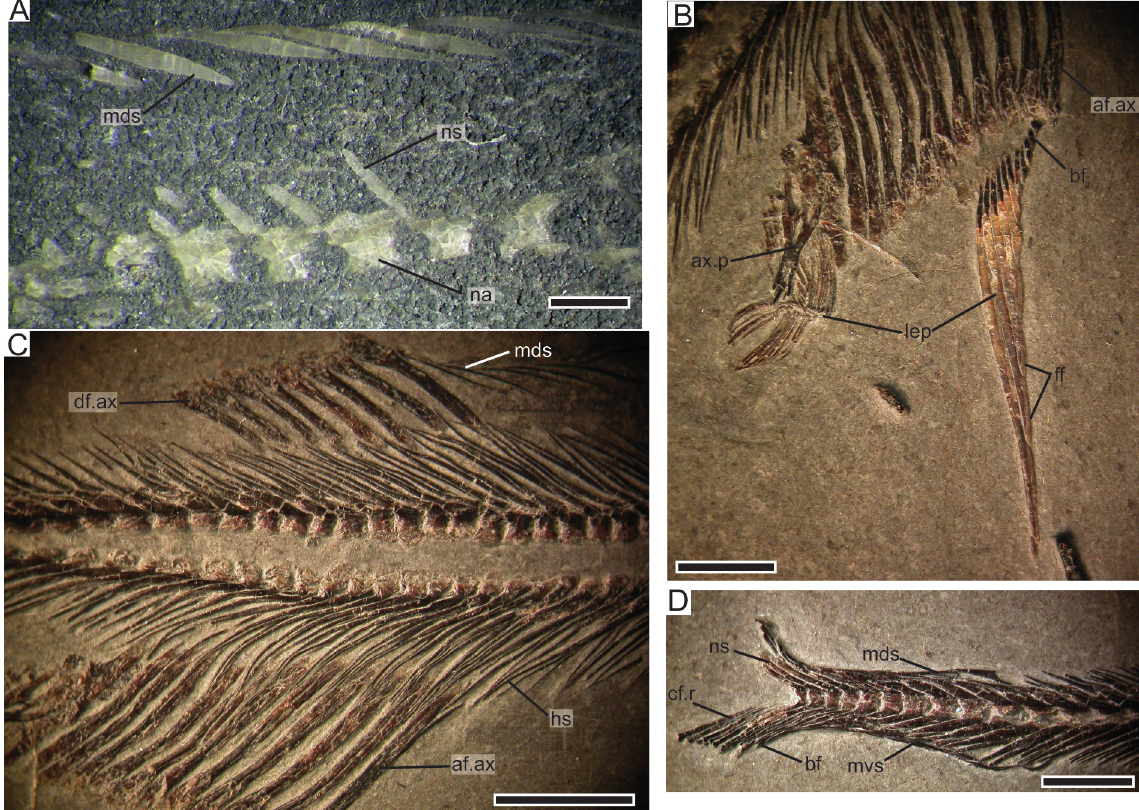
Fig. 7. Postcranium, Early Jurassic saurichthyids. A . Saurorhynchus anningae sp. nov., neural arches and squamation in the posterior abdominal region (NHMUK PV P 3790). B–D . Saurorhynchus hauffi sp. nov., SMNS 55057. B . Lepidotrichia of the anal fin. C . Relationship between the neural and haemal arches and the axonosts. D . Caudal peduncle. Abbreviations: af.ax = axonosts of the anal fin; ax.p = axonost plate; bf = basal fulcra; cf.r = caudal fin radials; df.ax = axonosts of the dorsal fin; ff = fringing fulcra; hs = haemal spine; lep = lepidotrichia; mds = mid-dorsal scale row; mvs = mid-ventral scale row; na = neural arch; ns = neural spine. Scale bars: A = 1 mm, B–D = 5 mm. A. Photo © The Trustees of the Natural History Museum,